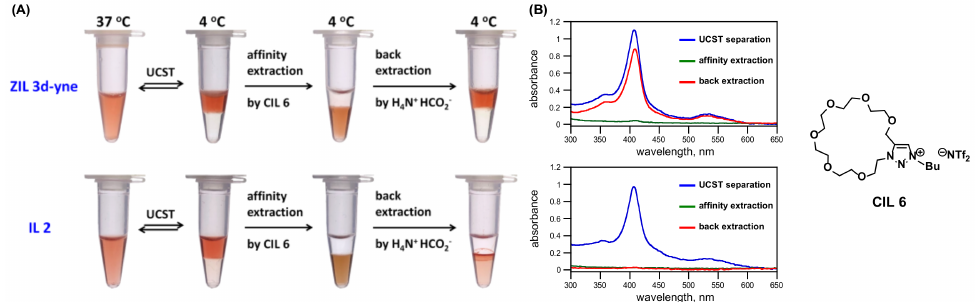
Figure 8. ( A ) Optical photographic images and ( B ) UV-vis spectra of thermoresponsive phase separation were exploited for demonstrating affinity extraction of protein by CIL 6 (163 mM) from its aqueous mixtures (1:1, w / w ) of ZIL 3d-yne with a solution of equine heart cytochrome c (0.3 mM). After affinity extraction, competitive extraction of cytochrome c in bottom ionic liquid layer into upper aqueous phase could be readily achieved using ammonium formate (0.5 M). Efficiencies of extractions of cytochrome c were quantitatively measured in upper aqueous layers using the Soret band at 410